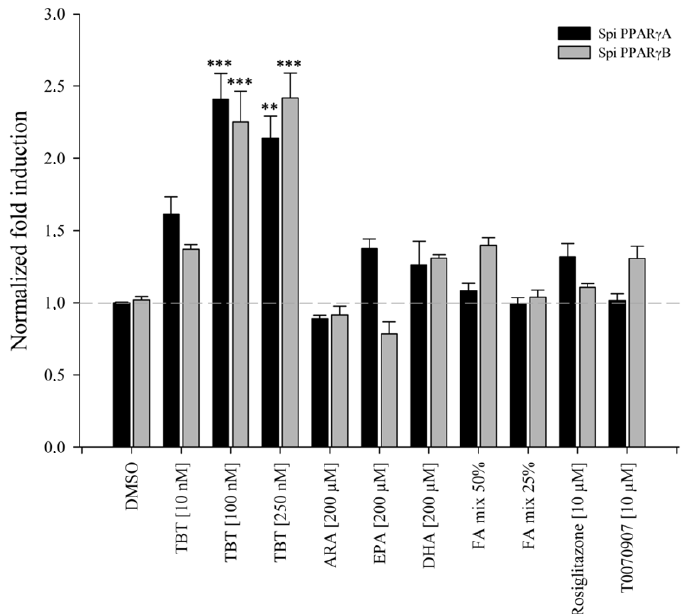
Figure 4. Results of transactivation assays with European sardine PPAR γ A and PPAR γ B. In these assays, transiently transfected COS-1 cells were exposed to three concentrations of tributyltin chloride (TBT; 10 nM, 100 nM and 250 nM), two concentrations of a mixture of seven fatty acids (FA mix; 50% and 25%) and one concentration of arachidonic acid (ARA, 200 µM), eicosapentaenoic acid (EPA, 200 µM), docosahexaenoic acid (DHA, 200 µM), rosiglitazone (human PPAR γ agonist; 10 µM) and T0070909 (human PPAR γ antagonist; 10 µM). Dimethyl sulfoxide (DMSO; 0.1%) was used as solvent control. Data are shown as mean ± standard error of the mean (SEM). Legend: ** and *** shows a statistically significant response of p ≤ 0.01 and p ≤ 0.001, respectively, when compared to DMSO.